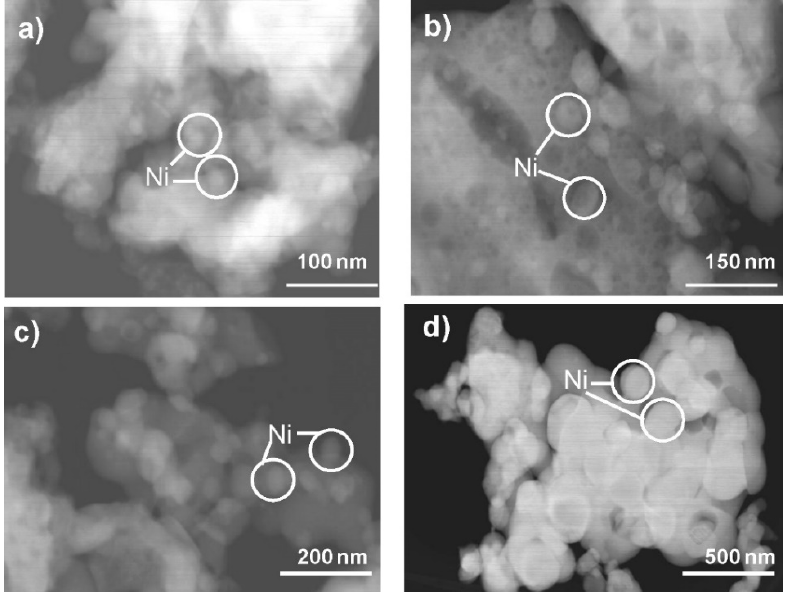
Figure 27. HAADF images for Ni/La 0.7 Sr 0.3 AlO 3 −δ sintered at ( a ) 800 °C, ( b ) 900 °C, ( c ) 1000 °C, and ( d ) 1100 °C (Reprinted with permission from [112]). and ( d ) 1100 ◦ C (Reprinted with permission from